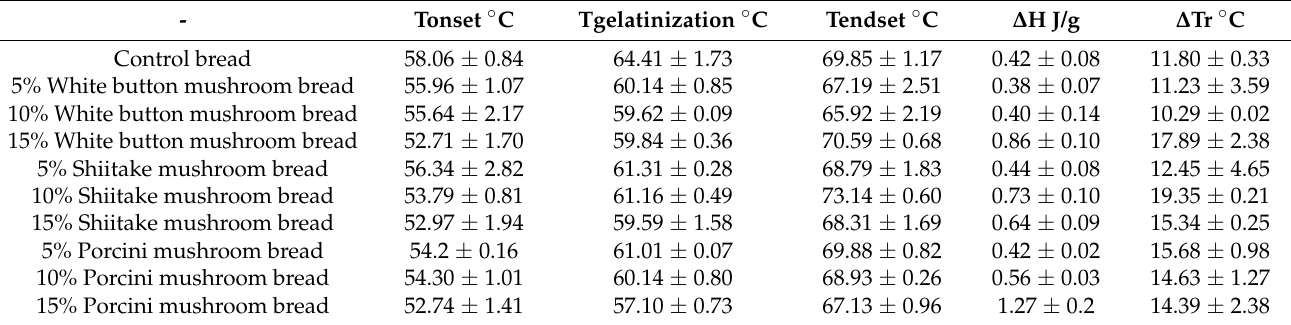
Table 1. The effect of different mushroom powder on the thermal properties of bread.